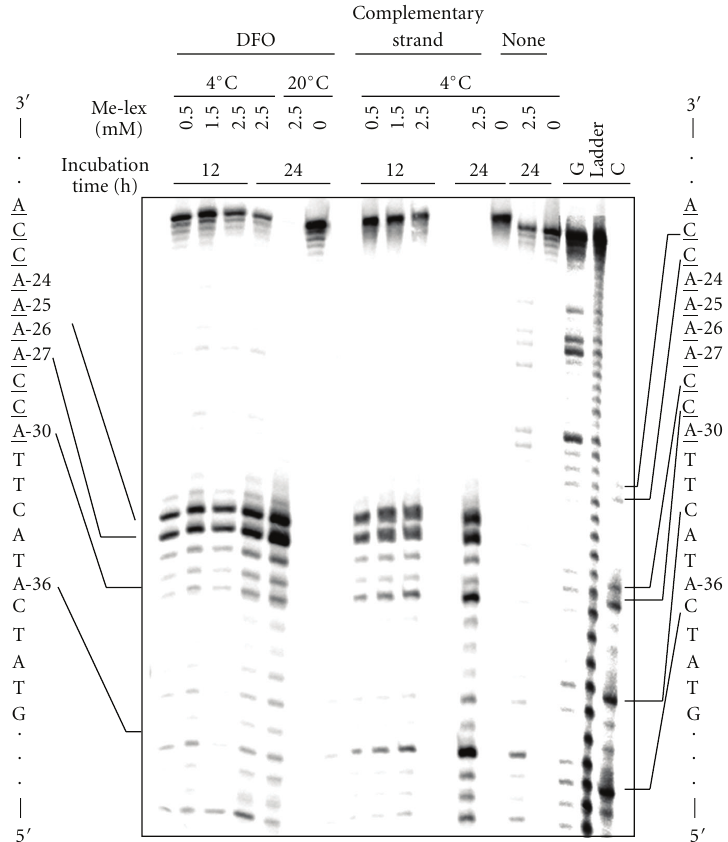
Figure 1: The A 4 tract sequence is methylated selectively by Me-lex at A-27 and A-26. Maxam-Gilbert chemical sequencing of methylation pattern in 5 (cid:2) -[ 32 P]-labeled unmodified sequence (Table 1) by Me-lex at 4 ◦ C and 20 ◦ C with 12 or 24 hours incubation times in the presence of: the 10 nt duplex forming oligomer (DFO), which overlaps with underlined bases on the labeled strand, with 0.5, 1.25 or 2.5mM Me-lex (12 hours) or 0 or 2.5mM Me-lex (24 hours); the full complementary strand with 0, 1.25 or 2.5 mM Me-lex (12 hours) or 0 or 2.5 mM Me-lex (24 hours); no complementary strand (none) with 0 or 2.5 mM Me-lex (24 hours). Sequencing lanes (G, ladder and C) are on